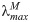
Plot of the sign of the maximum eigenvalue λmaxM of M^ as a function of the interaction for real networks and constant value of the self limitation term s.The inset of the figure indicates the number of the real network (1-9) shown in Table 1. The sign of the maximum eigenvalue λmaxM of M^ changes as a function of sγ where γ is the coupling term and this change of sign occurs at μmax = s where μmax is the maximum eigenvalue of the matrix Γ of the corresponding network. This is represented by the dotted line in this figure, therefore the value of γ for which Re(λmaxM)=0 coincides with the condition of the singularity obtained with the solution to the fixed point equation discussed in Section, i.e. γ for which Re(μmax) = 0 where Γ=γA^, for A^ being the adjacency matrix. The networks analyzed are labeled according to the references in Table 1. (Notice that networks 4 and 8 are overlapping).